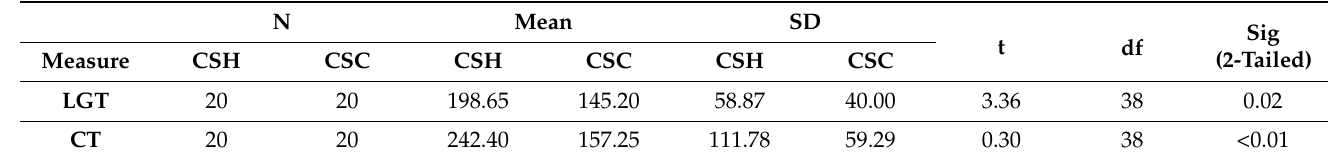
Table 3. Comparing the performances of CSH and CSC with regard to TW